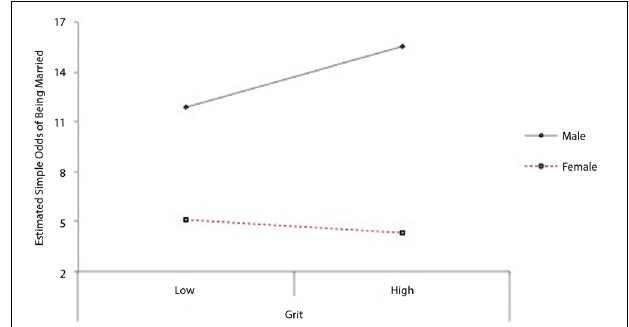
FIGURE 1 | Estimated simple odds of being married vs. divorced as a function gender and grit. Low ( − 1 SD ) and high ( + 1 SD ) grit are displayed on the x-axis. Control variables include gender, age, race, level of education, Big Five agreeableness, Big Five conscientiousness, and Big Five openness to